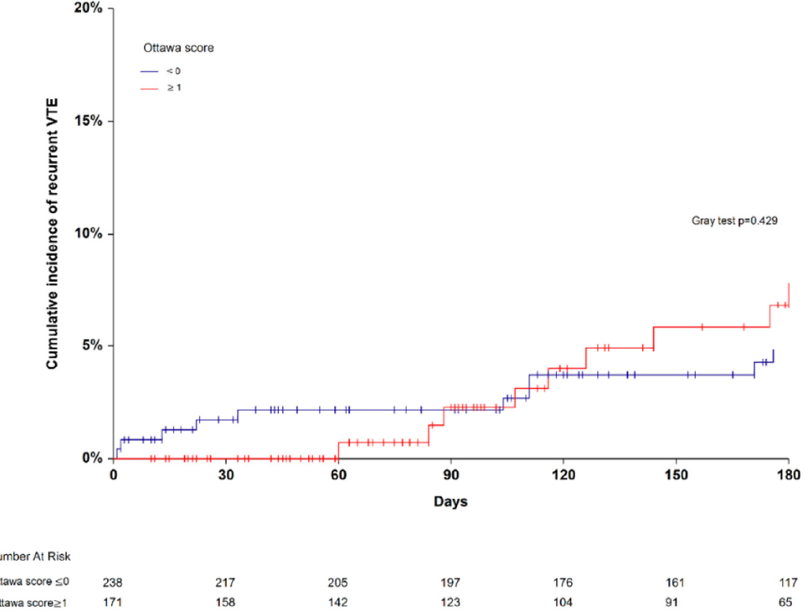
Figure 1. Six-month cumulative incidence of recurrent venous thromboembolism in patients with high- ( ≥ 1) and low-risk Ottawa score ( ≤ 0).